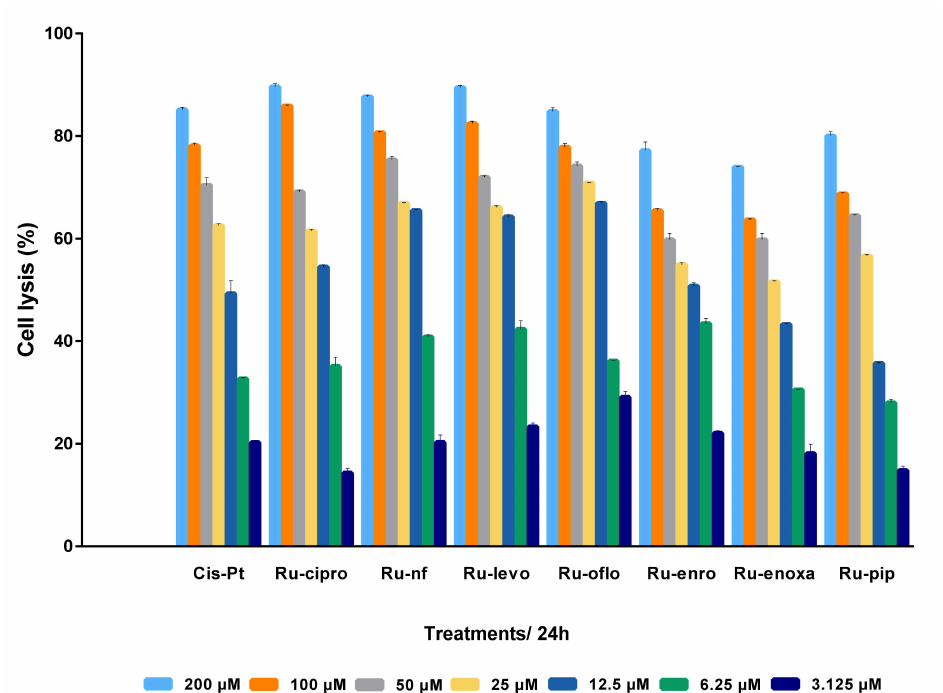
Figure 3. Antitumor effect of Ru(III) complexes against LoVo colon cancer cells. Cells lysis was induced by 24 h treatment with scalar concentrations of Ru(III) complexes or CisPt, and compared to untreated control LoVo cells. Data shown are expressed as mean values ± standard deviations (SD) of three different experiments ( n = 3